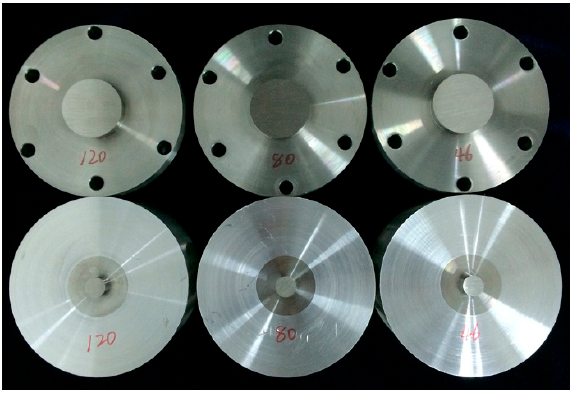
Figure 4. Specimens of 304 stainless steel.